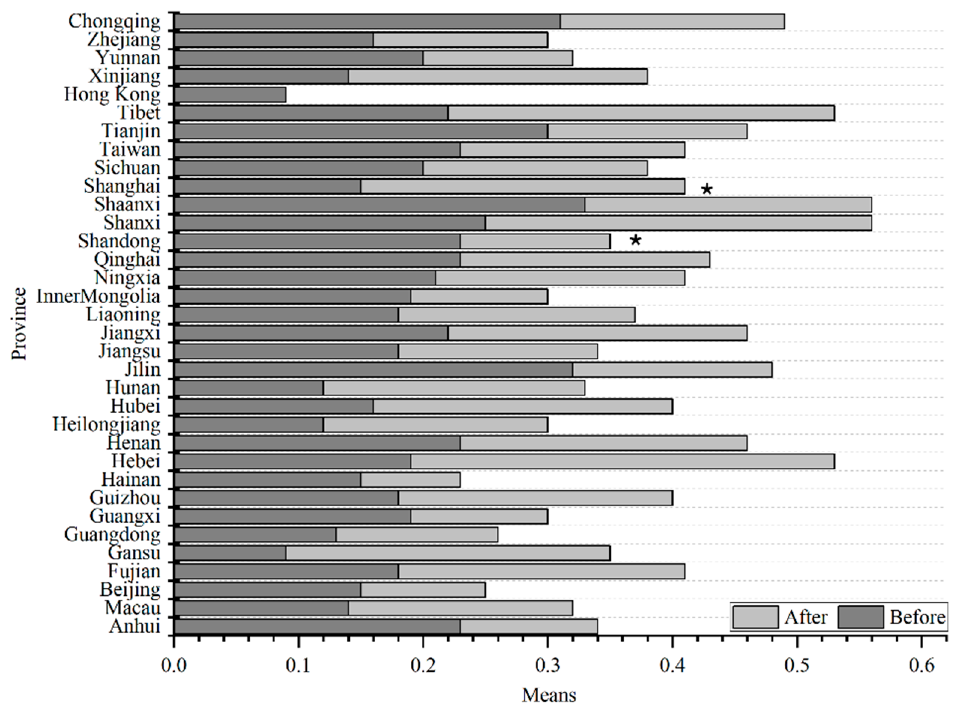
Figure 5. Temporal and spatial differences in implementation intention before and after release-type communication. Note: * means p < 0.05.